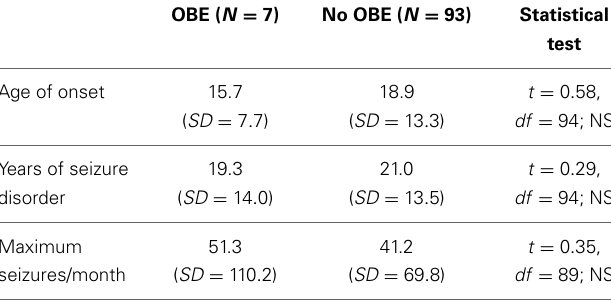
Table 5 | Seizure characteristics among patients with and without out-of-body experiences